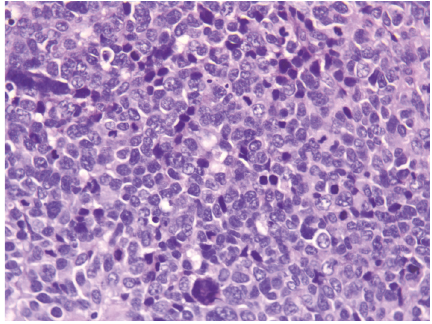
Figure 5: Same as Figure 4, higher magnification.